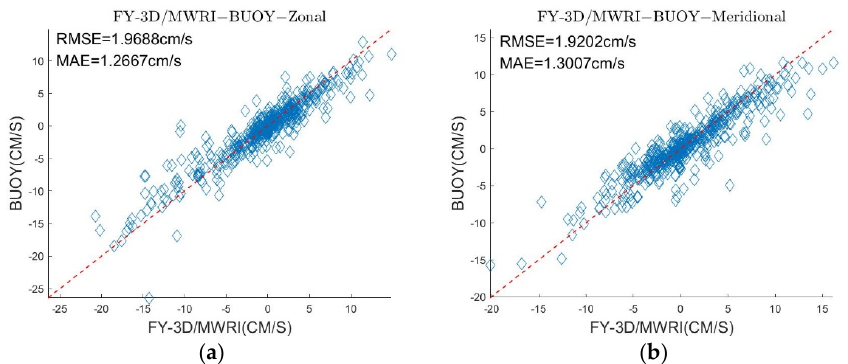
Figure 10. ( a ) is a comparison of the retrieved sea ice motion and one ‐ third of the buoy motion data in the zonal direction. ( b ) is a comparison of the retrieved sea ice motion and one ‐ third of the buoy motion data in the meridional direction.